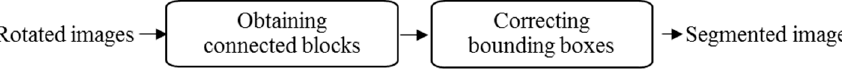
Figure 5. Flow of image segmentation.